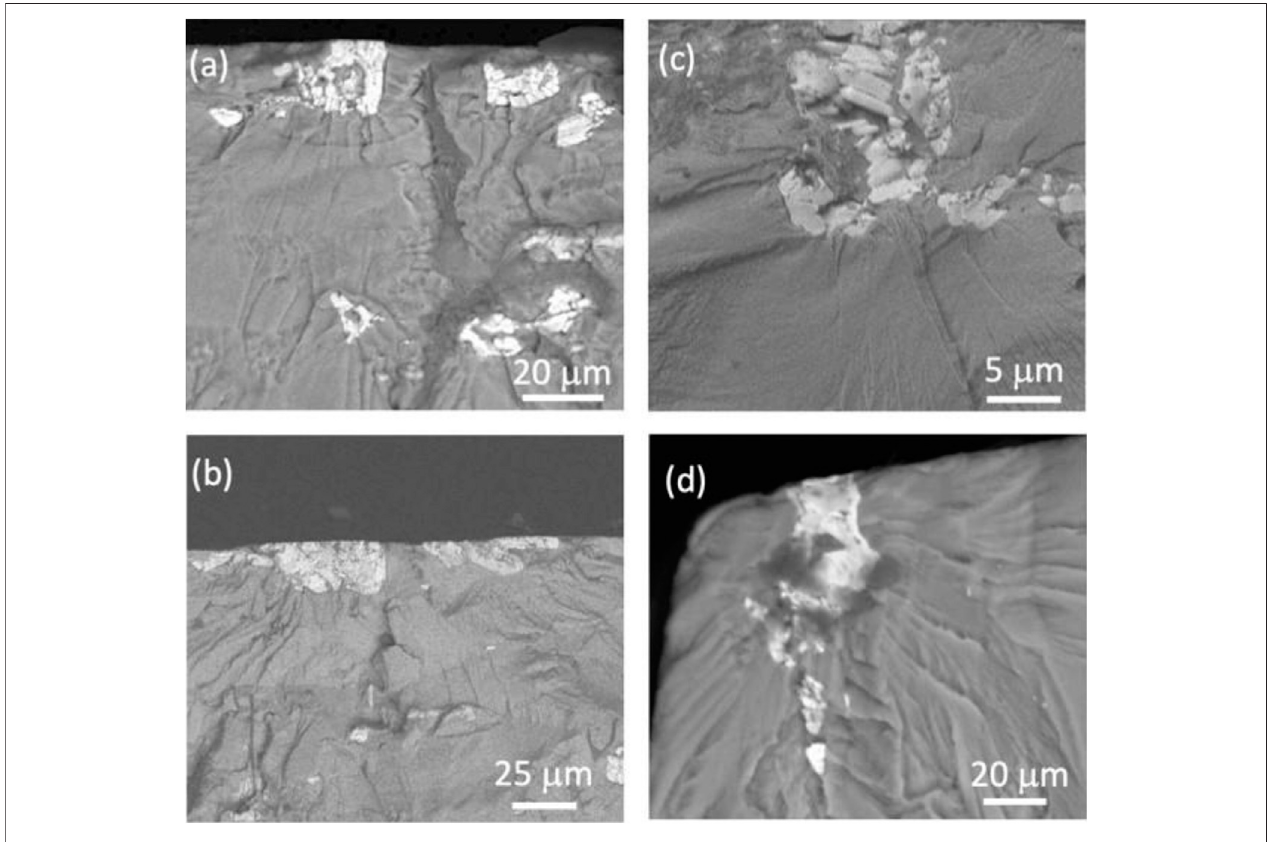
FIGURE 6 | Representative back-scatter electron (BSE) images of iron-rich intermetallic particles that initiated fatigue cracks in the (A) , (B) low cycle fatigue (LCF) and the (C) , (D) high cycle fatigue (HCF) regimes. Note that the iron-rich intermetallic particles are brighter compared to the darker aluminum matrix.